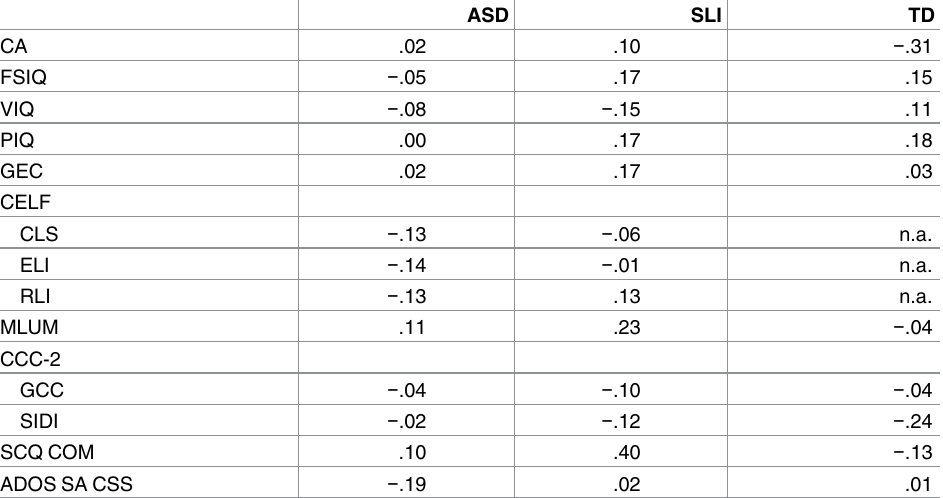
Table 8. Results for exploratory analysis of content versus non-content mazes. ASD SLI TD CA .02 .10 − .31 FSIQ − .05 .17 .15 VIQ − .08 − .15 .11 PIQ .00 .17 .18 GEC .02 .17 .03 CELF CLS − .13 − .06 n.a. ELI − .14 − .01 n.a. RLI − .13 .13 n.a. MLUM .11 .23 − .04 CCC-2 GCC − .04 − .10 − .04 SIDI − .02 − .12 − .24 SCQ COM .10 .40 − .13 ADOS SA CSS − .19 .02 .01 Associations between per-child content mazes (versus filler) use and age, intellectual ability, executive function, language, and social ability, as measured by Kendall’s τ b . Children in the TD group did not complete the CELF. CA = chronological age in years; FSIQ = full-scale IQ; VIQ = verbal IQ; PIQ = performance IQ; GEC = BRIEF global executive composite; CLS = CELF core language score; ELI = CELF expressive language index; RLI = CELF receptive languageindex; MLUM = mean length of utterance in morphemes; GCC = CCC-2 general communication composite; SIDI = CCC-2 social-interaction deviance index; SCQ COM = SCQ communication total score [66]; ADOS SA CSS = ADOS-G social affect calibrated severity score; there were no statistically significant differences at P = .05 after correction for false discovery rate